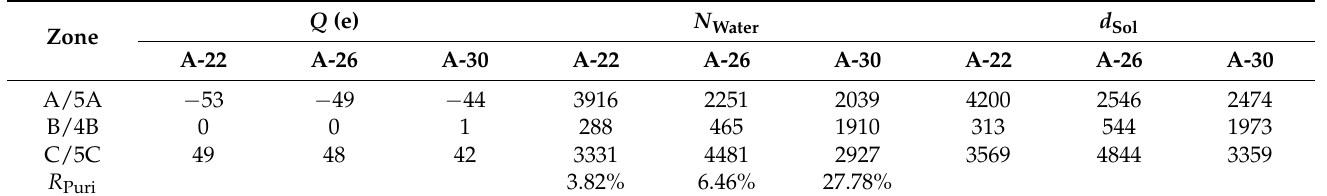
Table 3. Physical quantities of the solution separated by the three subchannels at 5 ns.